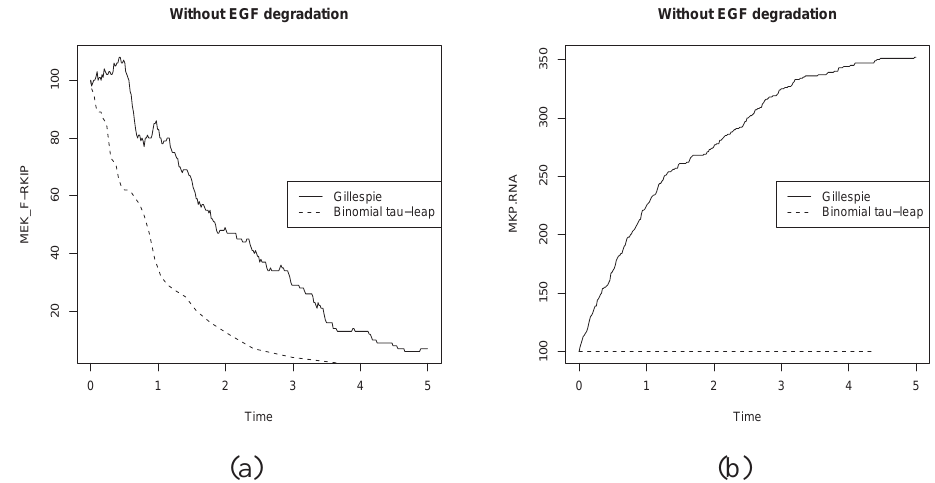
Figure 3: (a) Inactive, mono-phosphorylated MEK and RKIP complex in cytosol and (b) RNA sequence of MKP in nucleus simulated by the Gillespie algorithm and Binomial τ -leap method with f = 10 2 under the first scenario and t = 5 . The y -axes stand for the number of molecules of the underlying substrates for the time t